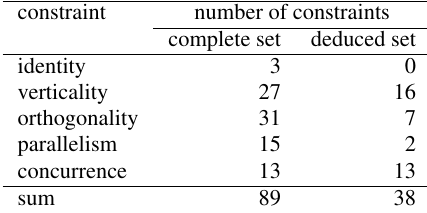
Table 2: Recognized and actually required constraints for the ad-